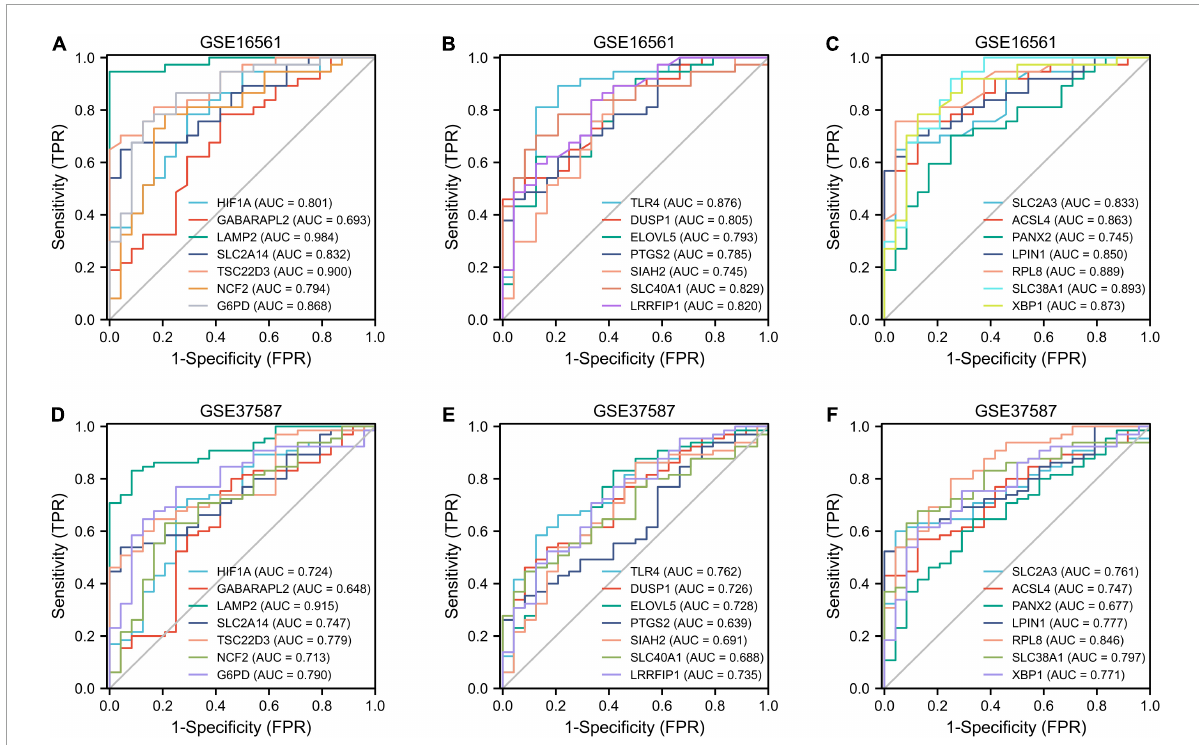
FIGURE6 ROC analysis. Diagnostic ROC analysis of 21 ferroptosis-related genes in GSE16561 (A–C) and GSE37587 (D–F) . ROC, receiver operating characteristic; AUC, area under curve; FPR, false positive rate; TPR, true positive rate.